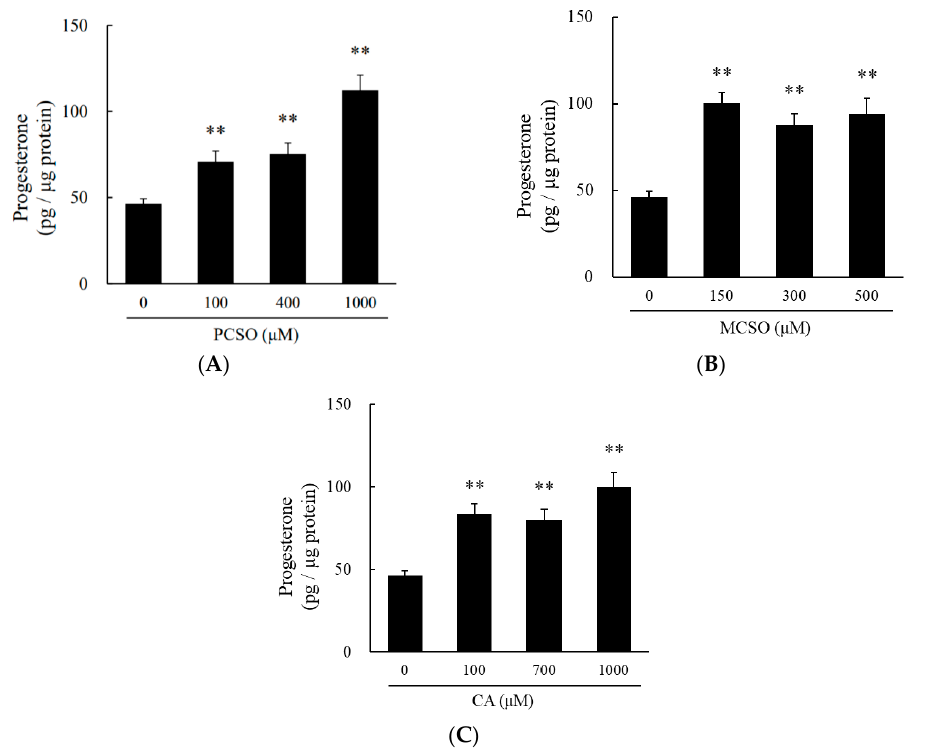
Figure 3. Effects of ( A ) PCSO, ( B ) MCSO, and ( C ) CA on progesterone production in I-10 cells. Data are presented as mean ± standard deviation ( n = 3). ** p < 0.01 vs. control group. PCSO: propenyl-l-cysteine sulfoxide; MCSO: S-methyl-L-cysteine sulfoxide; CA: cycloalliin.